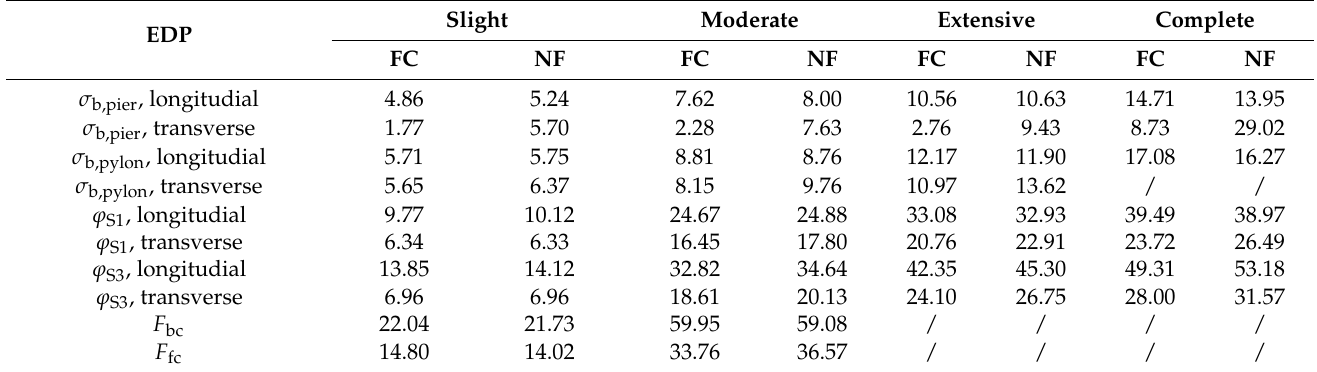
Table 9. Median V rms across different damage states for fault-crossing and near-fault bridges (unit: cm/s). Slight Moderate Extensive EDP